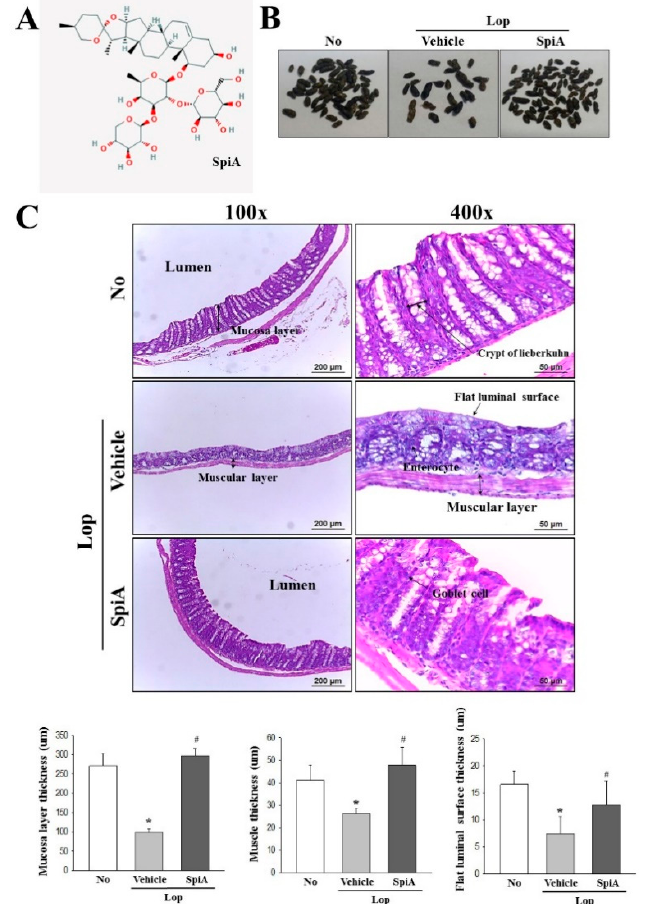
Figure 1. Stools image and histological structures of colon in Lop-induced constipation ICR mice model after SpiA treatment. ( A ) Chemical structure of SpiA. ( B ) Stool images of subset groups. The number of stools were measured in No, Lop + Vehicle and Lop + SpiA treated groups. Five to six mice per group were used in collection of stools. ( C ) H&E stained sections of colon from the No, Lop + Vehicle or Lop + SpiA treated groups were observed at 100 × (left column) and 400 × (right column) magnification using a light microscope. Five to six mice per group were used in preparation of colon tissue slide and three parameters were assayed in duplicate in two H&E stained slide. Histopathological parameters were determined using the Leica Application Suite (Leica Microsystems). Data are reported as the mean ± SD. *, p < 0.05 compared to the untreated group. # , p < 0.05 compared to the Lop + Vehicle treated group. No, Untreated group; Lop, Loperamide; SpiA, Spicatoside A, ICR; Institute of Cancer Research, H&E; Hematoxylin and